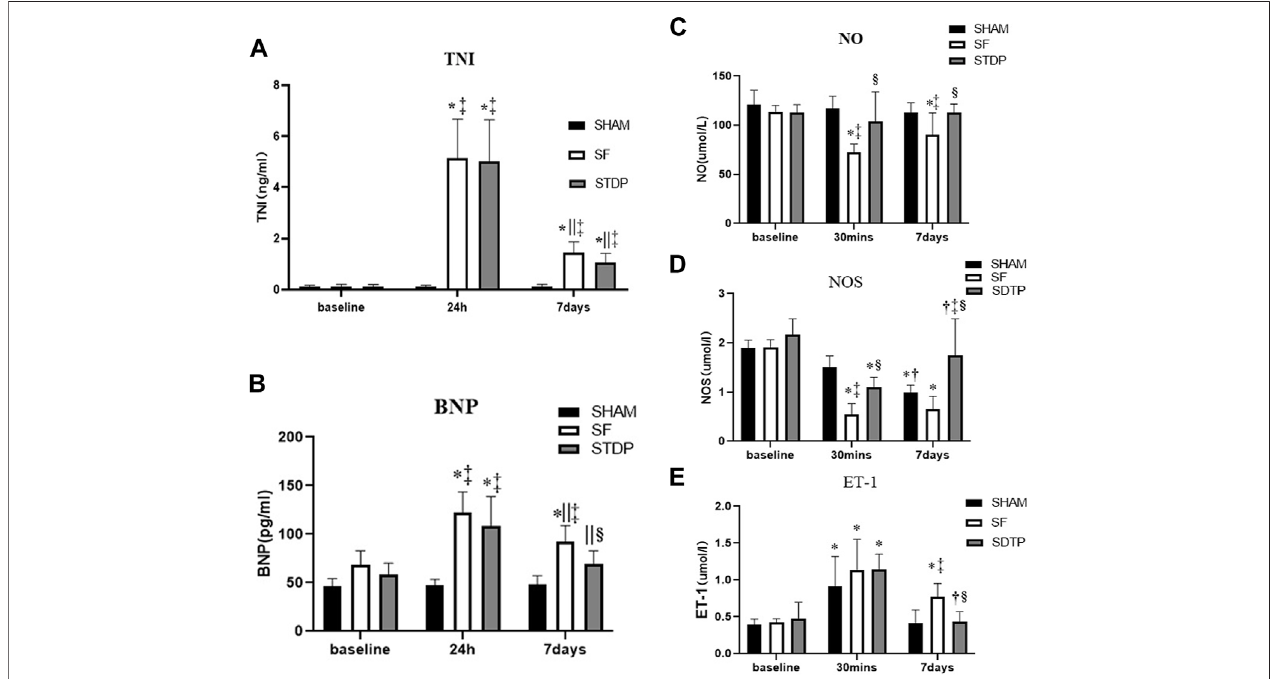
FIGURE2| Serumc-TNI,BNP,NO,NOS,andET-1levels. (A) Serumc-TNIlevel; (B) serumBNPlevel; (C) serumtotalNOlevel; (D) serumNOSlevel; (E) serumET- 1 level. Data are presented as the mean ± SD, p < 0.05 *vs. baseline, † vs. 30 min, ||vs. 24 h, ‡ vs. Sham group, and §vs. SF group ( n = 6 for each group).